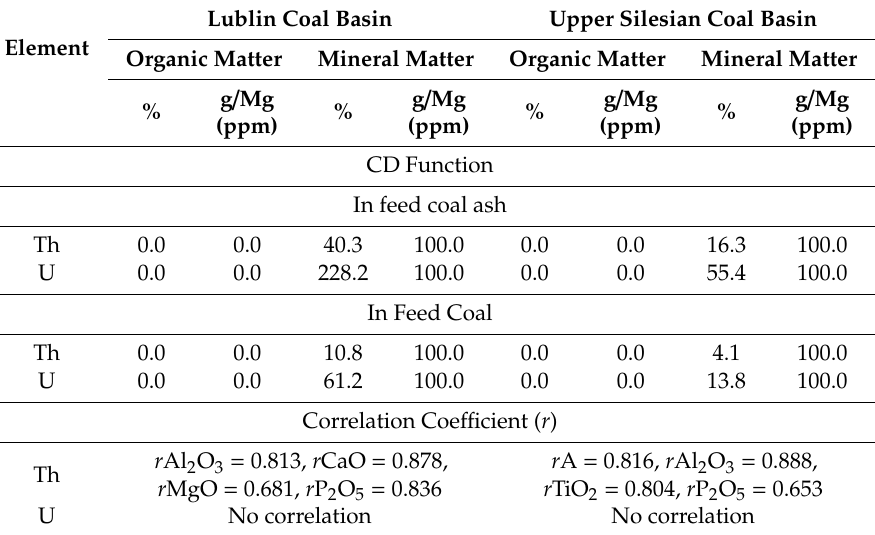
Table 4. The role of organic and inorganic matter in the concentration of Th and U in the feed coal from Lublin and Upper Silesian Coal Basin, resulting from the results of the CD function solution and the value of the correlation coe ffi cient between the content of Th and U and the content of major element oxides in feed coal and feed coal ash. Lublin Coal Basin Upper Silesian Coal Basin Element Organic Matter Mineral Matter Organic Matter Mineral Matter g / Mg g / Mg % % (ppm)